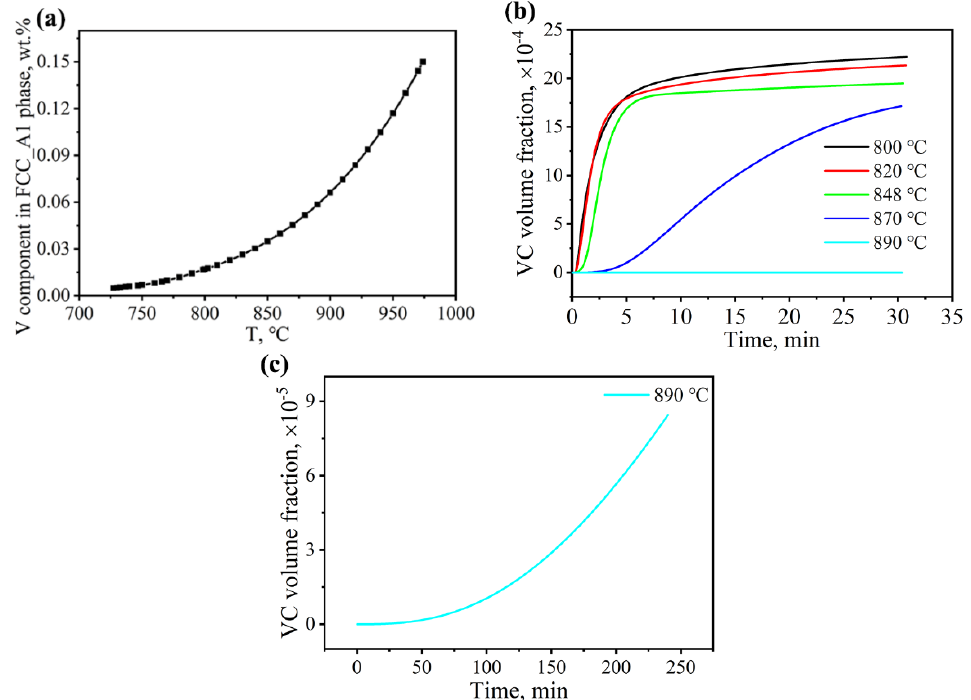
Figure 3. ( a ) V component in the austenite phase with the increase of the austenitization temperature; ( b ) and ( c ) Relationship between VC volume fraction and time.